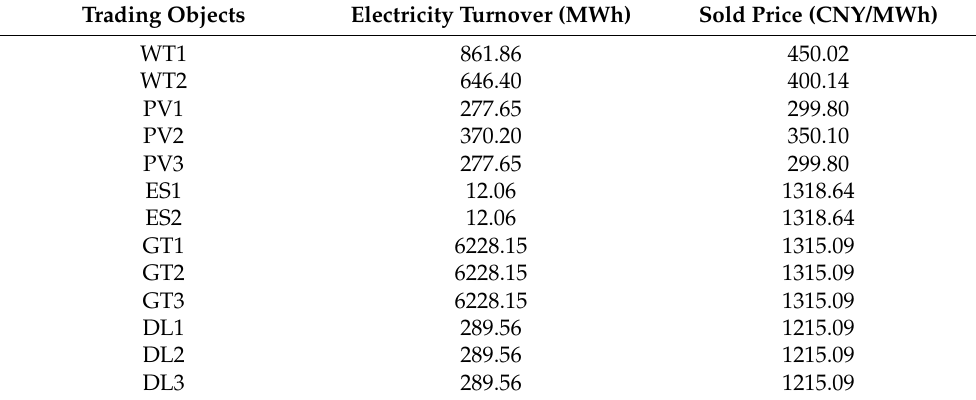
Table 3. Monthly